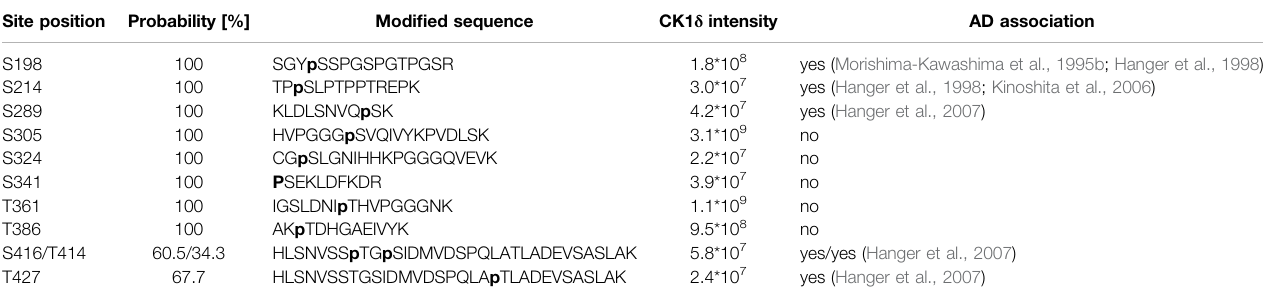
TABLE 1 | LC-MS/MS analysis of tau441 in vitro phosphorylated by CK1 δ . Tau441 was recombinantly expressed in E. coli and puri fi ed. Subsequently, tau441 was phosphorylated by CK1 δ in vitro , digested with trypsin and analyzed by LC-MS/MS. Positions of the identi fi ed phosphorylation sites within tau441 (indicated with p ) as well as phosphorylation probability data are